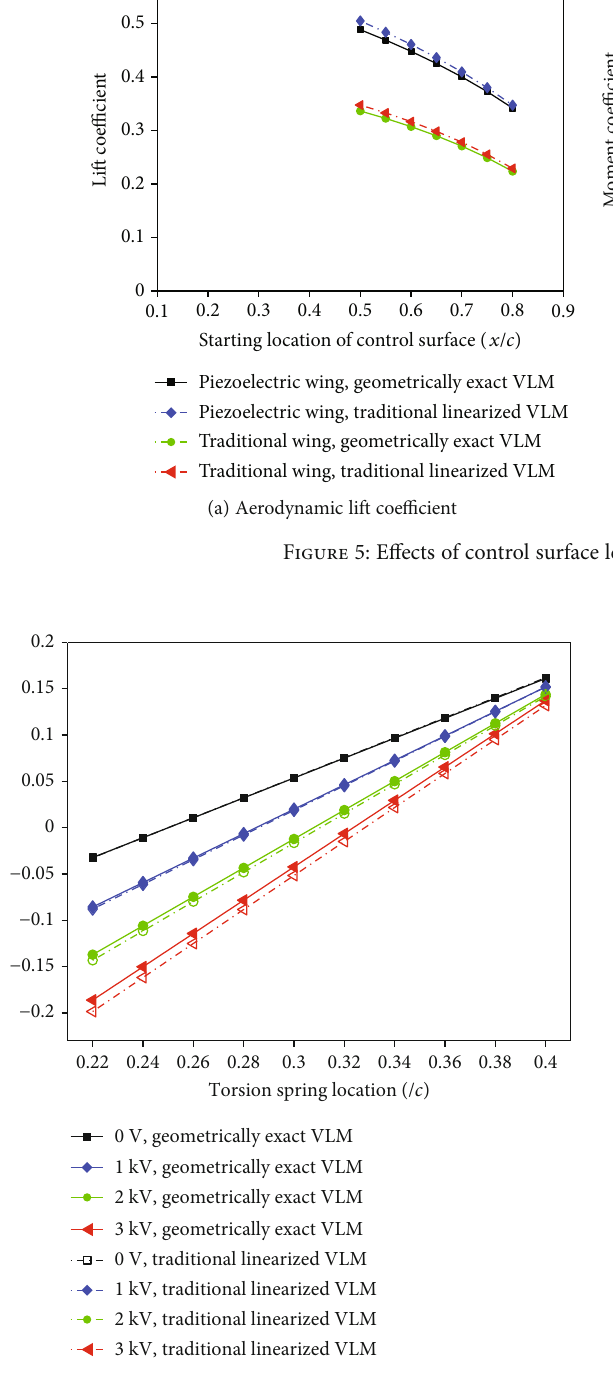
Figure 6: E ff ects of torsion spring location and driving voltages on aerodynamic